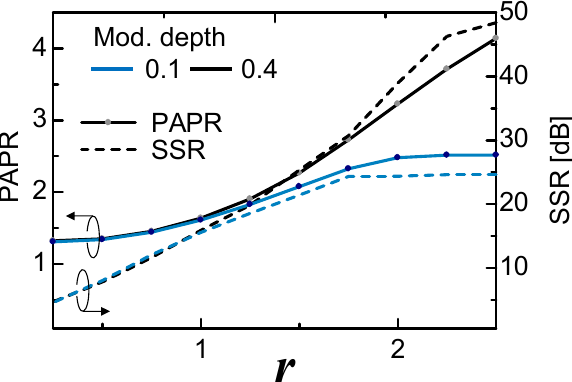
Figure 9. PAPR and SSR of peak clipped OSSB-SC signal for variable clipping voltage.